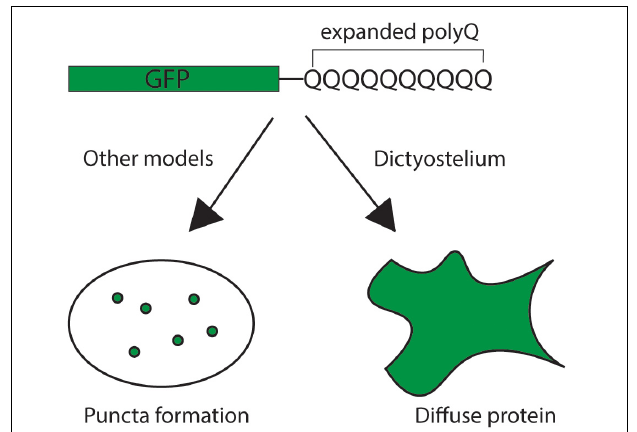
FIGURE 5 | Dictyostelium is resistant to polyglutamine aggregation. Expression of an exogenous, pathogenic GFP-tagged mutant huntingtin exon 1 protein with an expanded polyglutamine tract yields the formation of polyglutamine puncta in the cells of most model organisms, indicating protein aggregation ( left ). In Dictyostelium, however, the mutant huntingtin protein remains diffuse throughout the cell, indicating that the protein remains soluble ( right